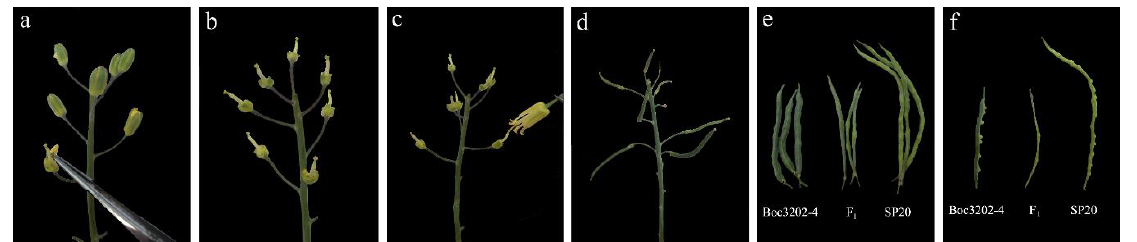
Figure 3. The process of artificial pollination between Boc3202-4 (HS, cauliflower, female parent) and UNICT5169 (HR, B. montana, male parent), and F 1 hybrid production. ( a ) Artificial stamens removal of Boc3202-4 buds. ( b ) Pistils of Boc3202-4 after the removal of stamens and petals. ( c ) UNICT5169 pollen was used for pollination of Boc3202-4 stigmas. ( d ) Developmental status of seed pods 15 days after cross-pollination. ( e,f ) Developmental status of seed pods 35 days after cross-pollination.